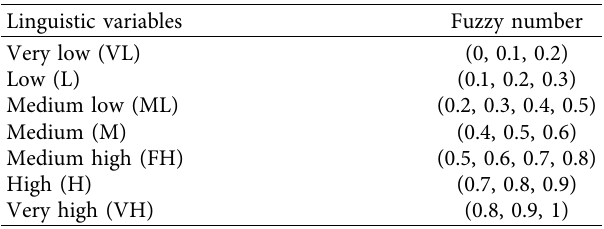
Table 3: The linguistic variables. Linguistic